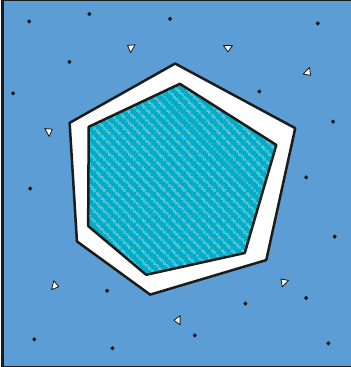
Figure 2: Convex aggregate concrete